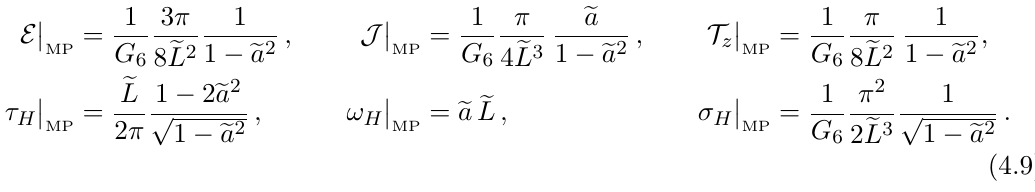
Figure 2 . Wavenumber corrections e k (2) (left panel) and e k (4) (right panel), as defined in (4.1b), as a function of the dimensionless angular velocity Ω r + = the extremal configuration with Ω H r + = 1 / figure